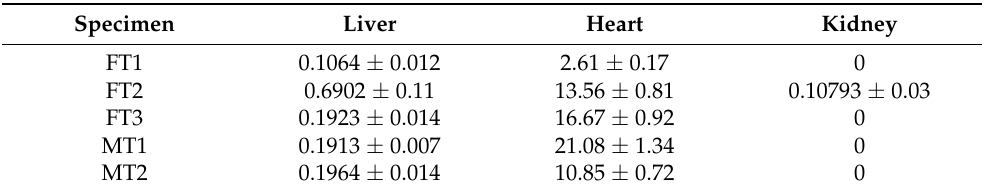
Table 2. Quantification chart of relative hDAF protein levels in each tissue analyzed for each transgenic specimen. Levels of hDAF protein were normalized to β -actin reference levels. Specimen Liver Heart Kidney